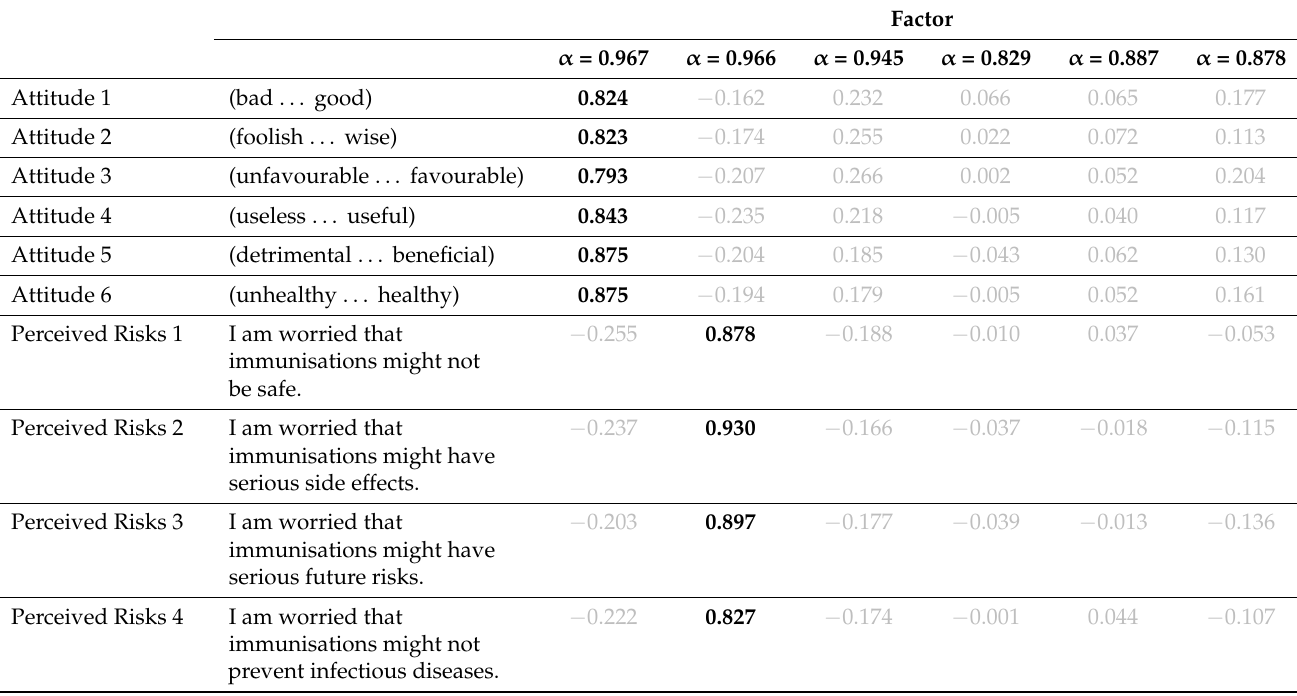
Table 4. Exploratory Factor